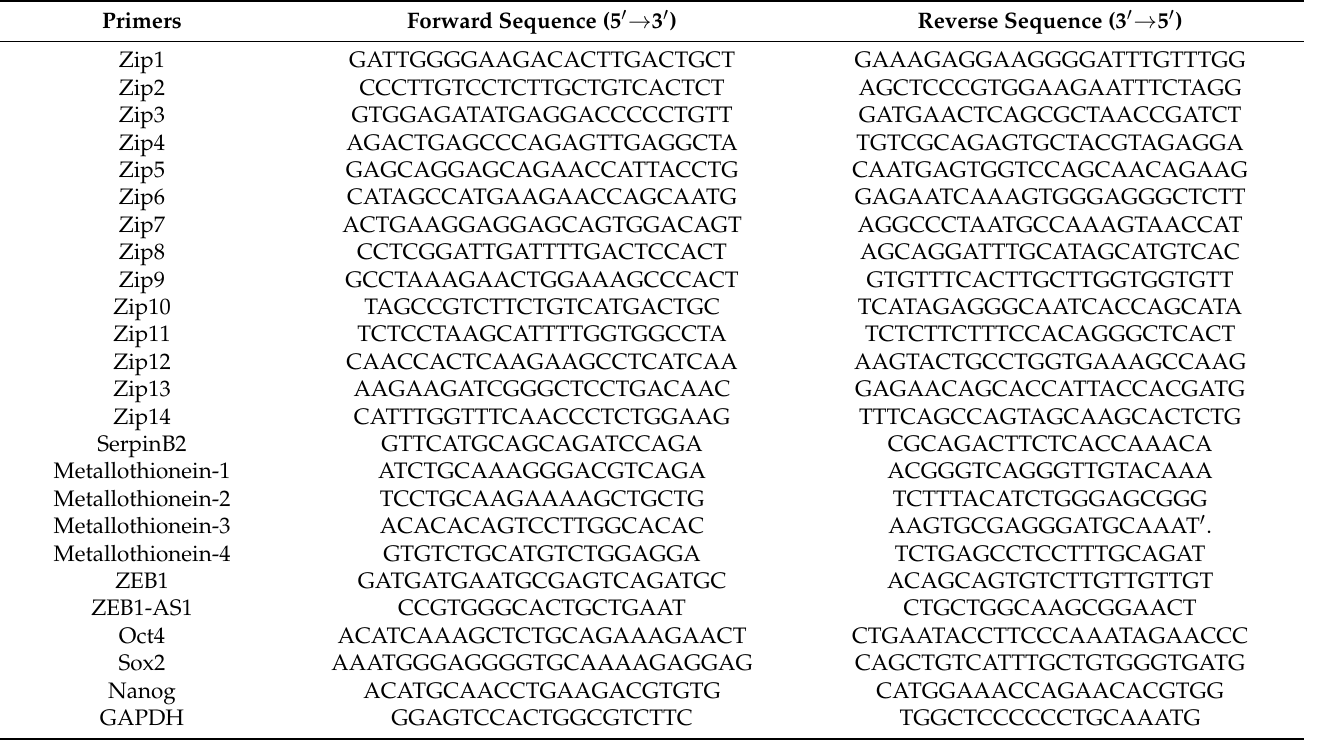
Table 1. Primers used for RT-PCR